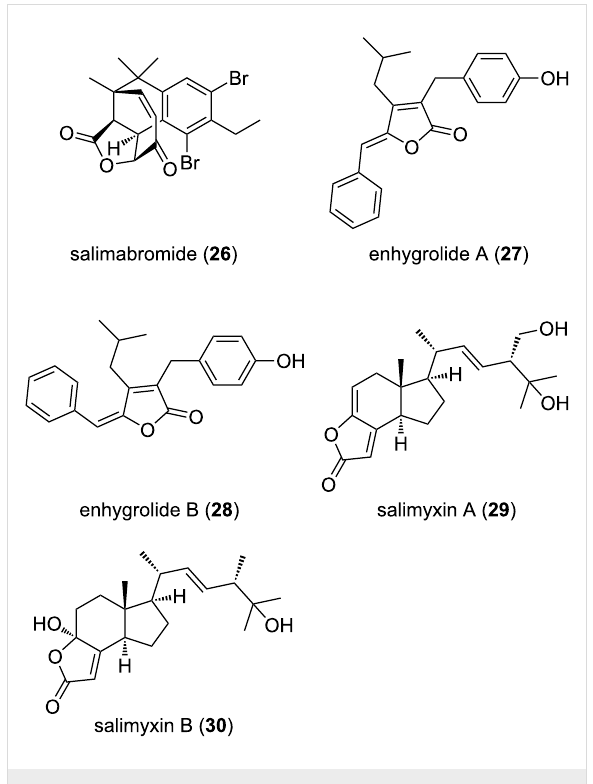
Figure 12: Structures of salimabromide, enhygrolides A + B and salimyxins A +